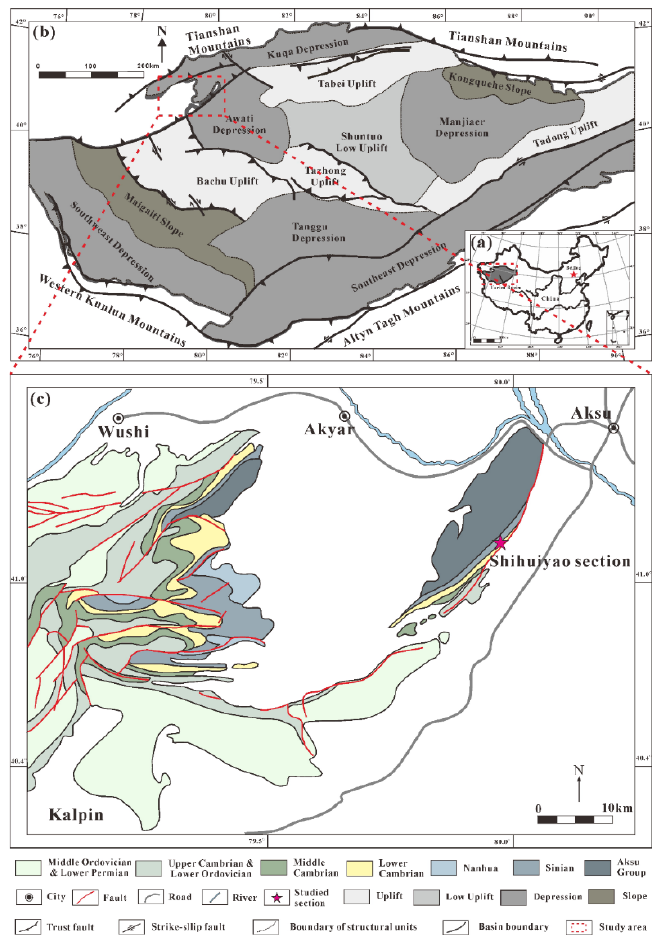
Figure 2. ( a ) Location of the Tarim Basin (modified from [50]). ( b ) Structural units of the Tarim Basin (modified from [51]). ( c ) Geological setting of outcrop section in the northwestern Tarim Basin (modified from